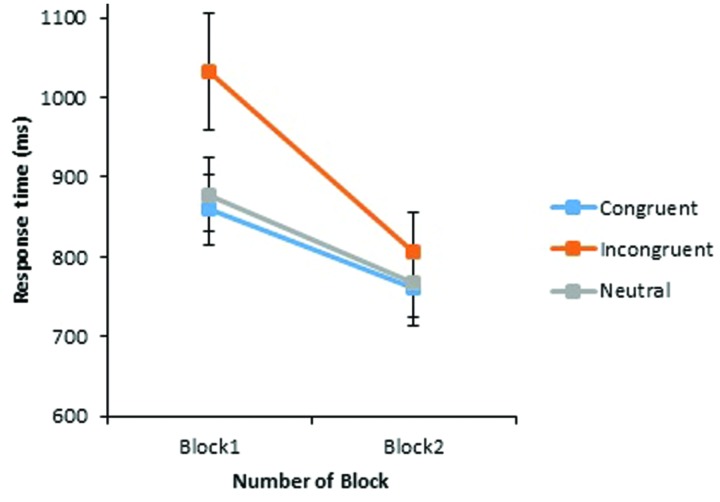
Experiment 1: mean response times (in milliseconds) of correct judgments to critical word pairs across Block 1 and Block 2. The vertical axis begins at 600 ms while error bars indicate the 95% confidence interval.